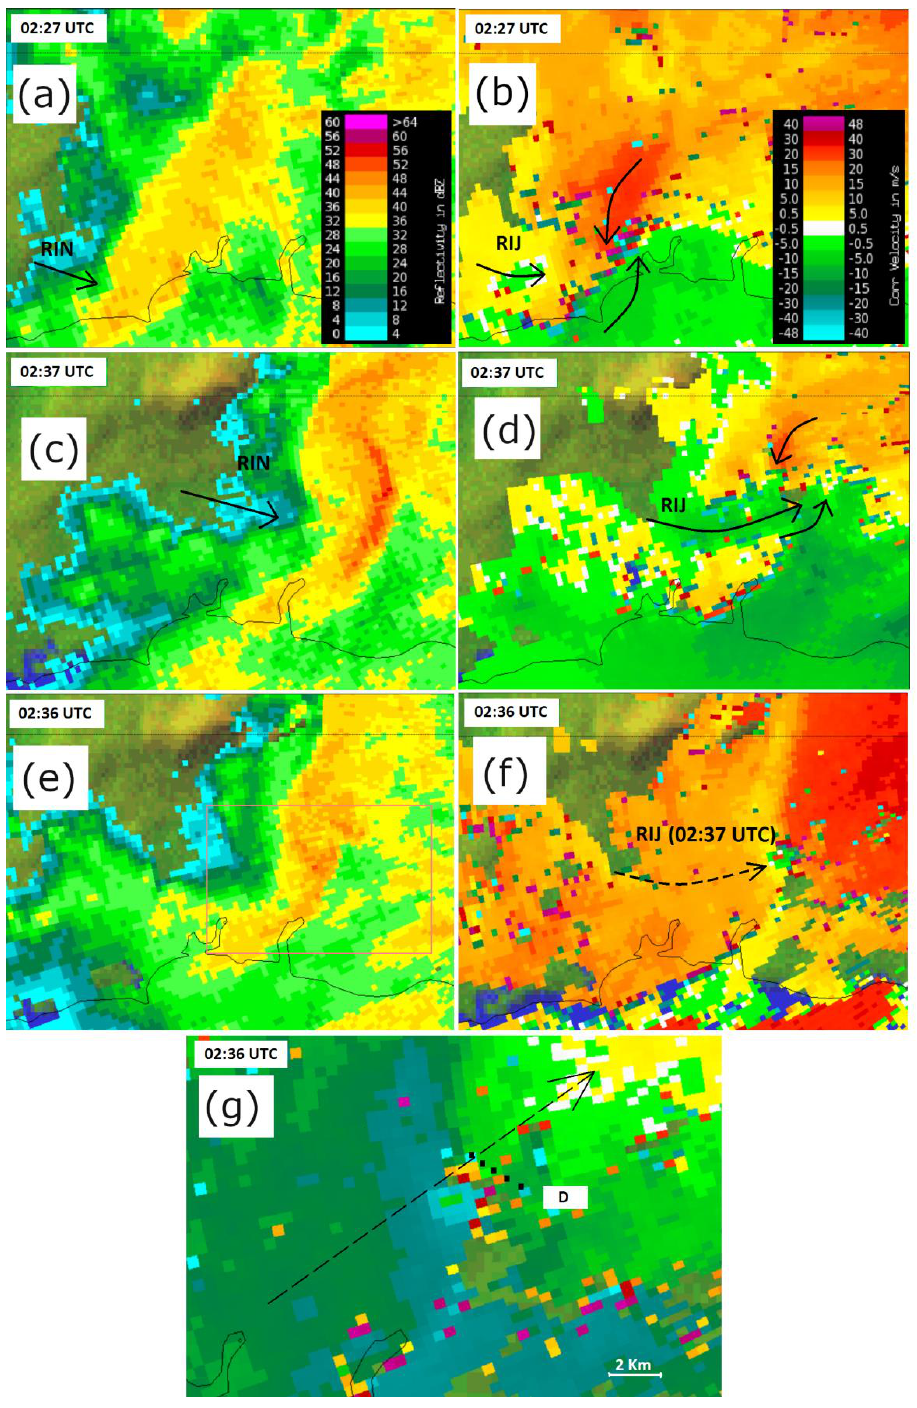
Figure 8. Time sequence (02:27–02:37 UTC) of radar reflectivity ( a ) and ( c ), and of storm-relative velocity ( b ) and ( d ), with PPI at 1.5° elevation, on the 23 December 2009. Black circular arrows represent the approximate circulation of the mesovortex, and RIN and RIJ signatures are also represented. Radar reflectivity (e) and storm-relative velocity ( f ) at 0.1° elevation, at 02:36 UTC on 23 December 2009. RIJ axis observed at 02:37 UTC (1.5°) is superimposed over the storm-relative observation at 02:36 UTC (1.0°), considering the average storm translation (36 m s −1 from 234°) advection. ( g ) Doppler velocity, PPI at 0.1° elevation. Dashed arrow represents the trajectory of the mesovortex and the 2.7-km-long path of the power towers’ destruction is marked by “D”.